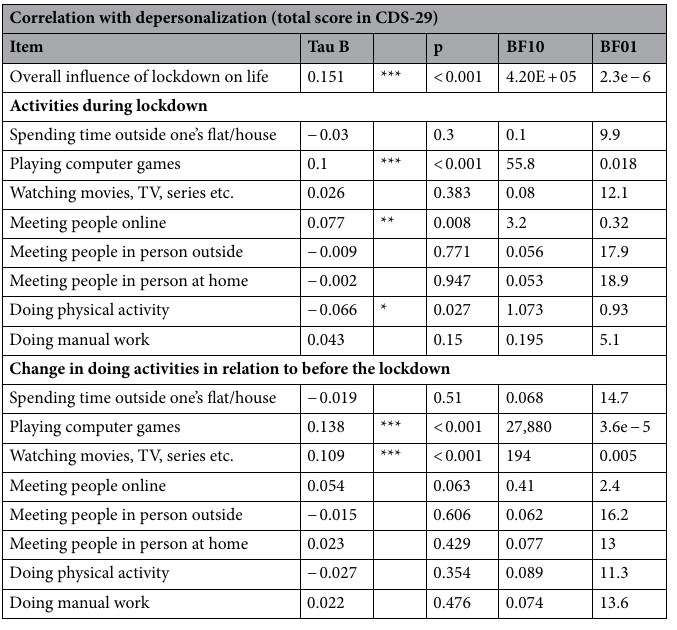
Table 3. Correlations between depersonalization and lifestyle habits. *** = significant at the 0.001 level, ** = significant at the 0.01 level, and * = significant at the .05